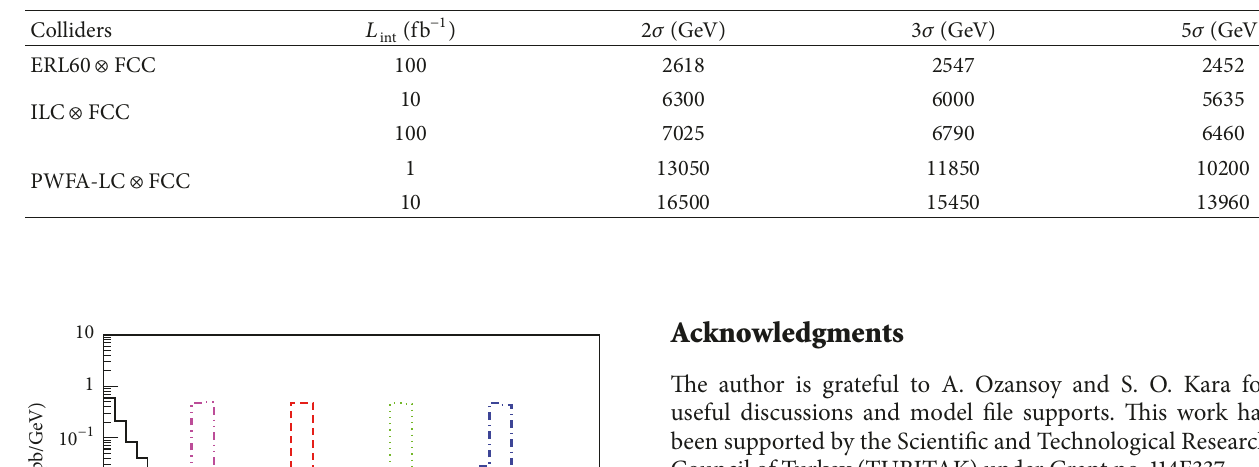
Table 5: The mass limits for the exclusion ( 2𝜎 ), the observation ( 3𝜎 ), and the discovery ( 5𝜎 ) of the excited neutrinos at the different 𝑒𝑝 colliders assuming the coupling 𝑓 = 𝑓 󸀠 = 1 and the energy scale Λ = 𝑚 ] ⋆ .